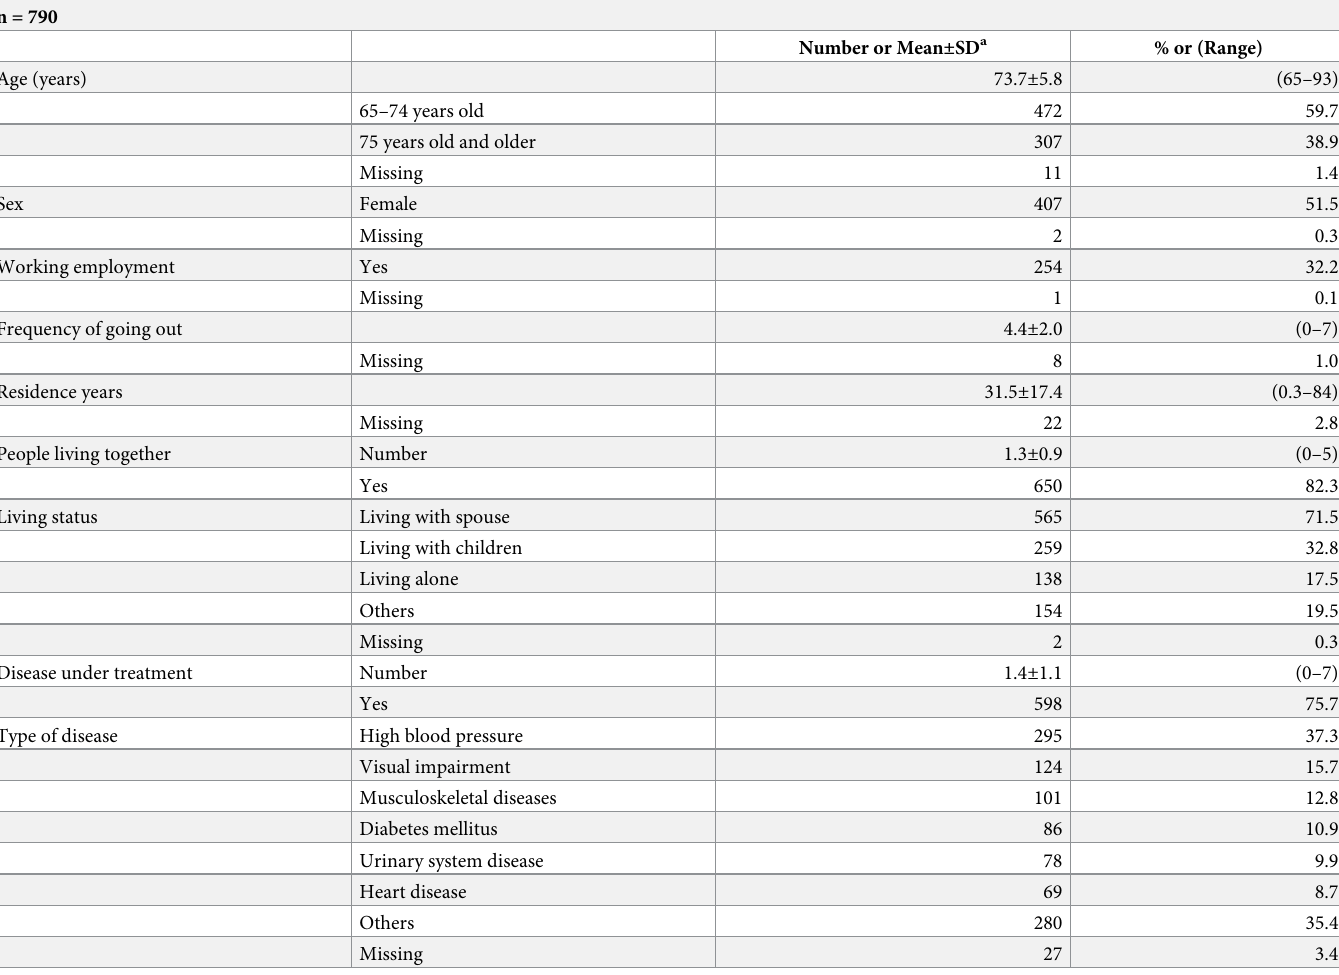
Table 1. Participants’ demographic